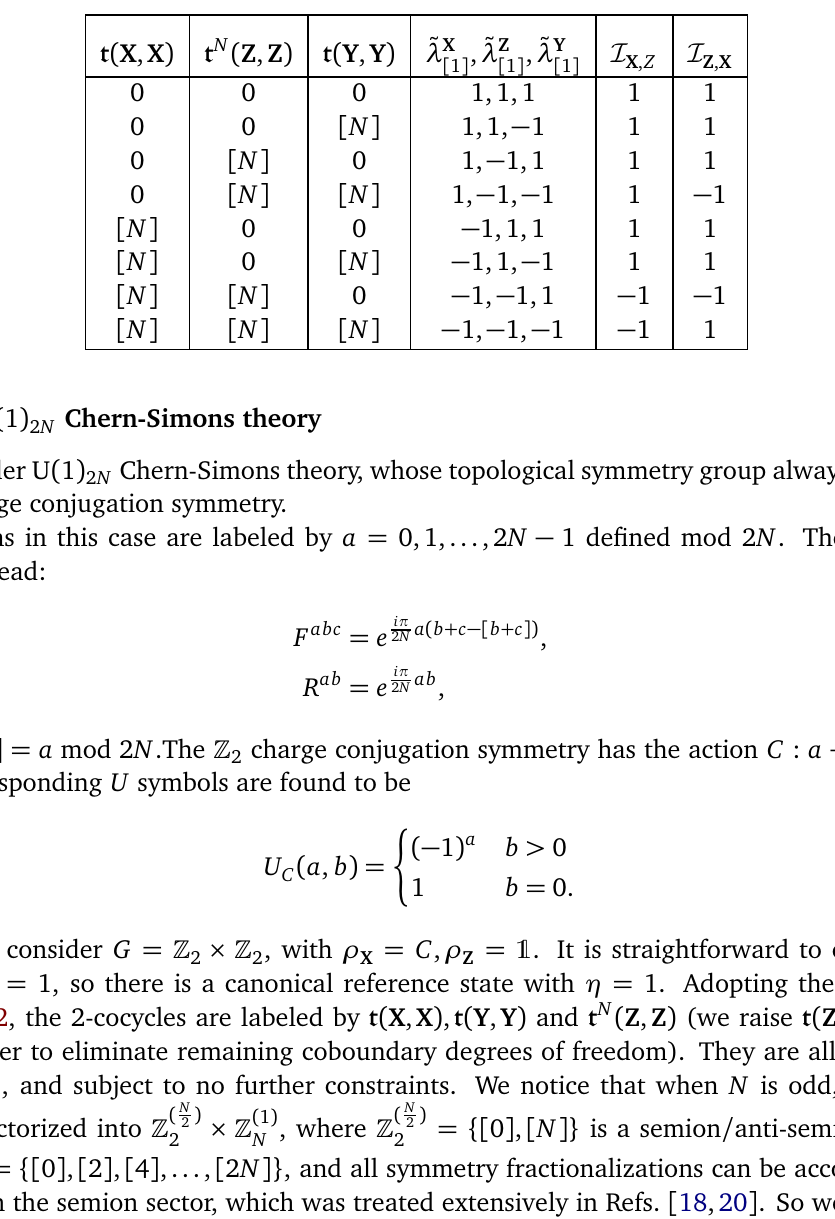
Table 1: Obstruction classes for Z